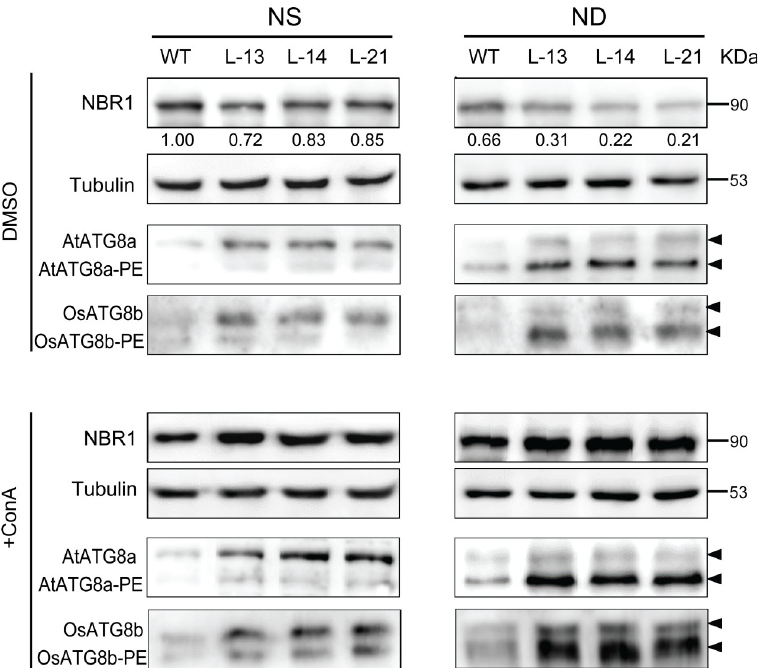
Fig 4. Overexpression of OsATG8b enhanced the autophagic flux in transgenic Arabidopsis. 9-day-old seedlings of transgenic lines and WT were transferred to NS or ND medium with 0.5 μ M ConA or solvent control DMSO for 24h. Immunoblot analysis the accumulation of NBR1 with anti-Arabidopsis NBR1, near equal protein loads were confirmed by immunoblot analysis with an α -tubulin antibody. The membrane fraction was used to detect the level of lipidated (ATG8-PE) and free ATG8 with Arabidopsis anti-AtATG8a or an anti-OsATG8b antibody. The number under the blot indicated the intensity ratios of the NBR1 protein in each line after analyzed by Image J and normalized to the WT under NS condition (value set to